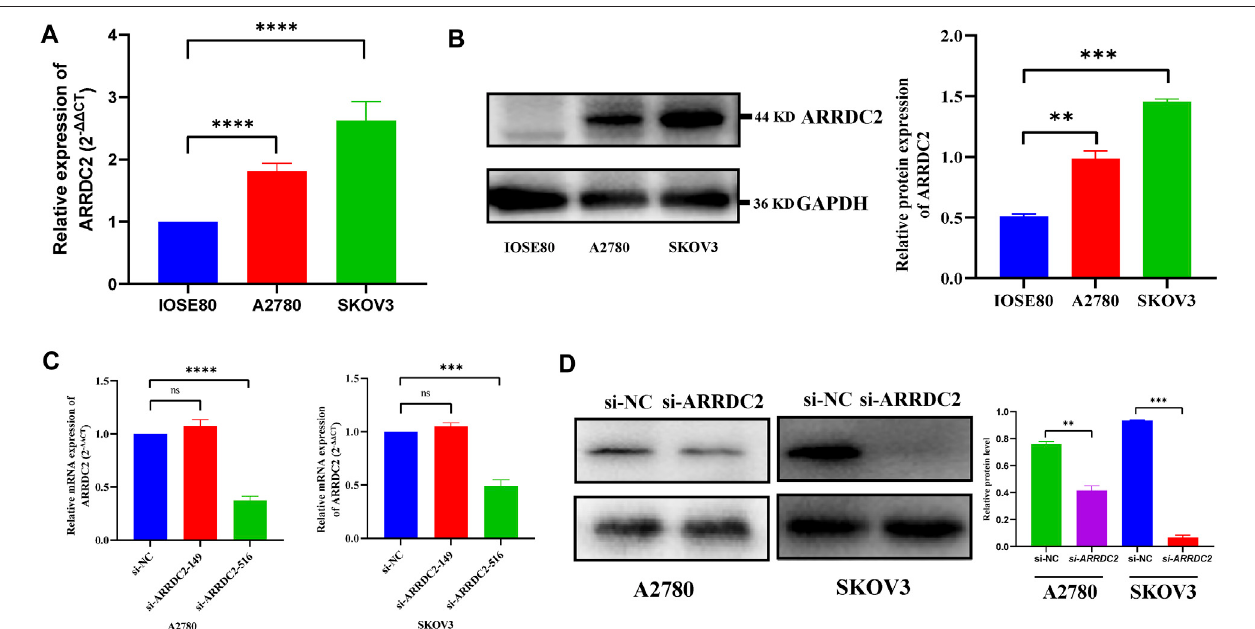
FIGURE8| Differential expression and the knockdown ef fi ciencyofARRDC2at the cellular level. (A) RT-qPCRexperimentalresults showed thatthe expression of ARRDC2inovariancancercellsishigherthanthatinnormalovariancells. (B) WesternblotexperimentalresultsshowedthattheexpressionofARRDC2inovariancancer cells ishigher than that in normal ovarian cells. Thedifferences in ARRDC2 gene expression levels in OC were compared at thecell levels by Wilcoxon rank sum test. (C) RT-qPCR after cell transfection. (D) Western blot image and corresponding statistics after cell transfection (* p < 0.05, ** p < 0.01, *** p < 0.001, **** p <